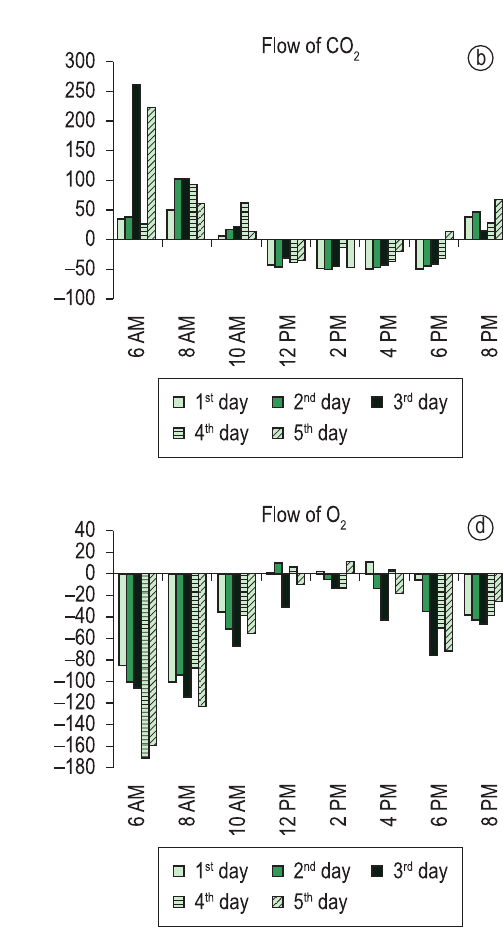
Figure 2. Diurnal variation in the concentrations of dissolved gases, their theoretical equilibrium value and respective flows in the interface